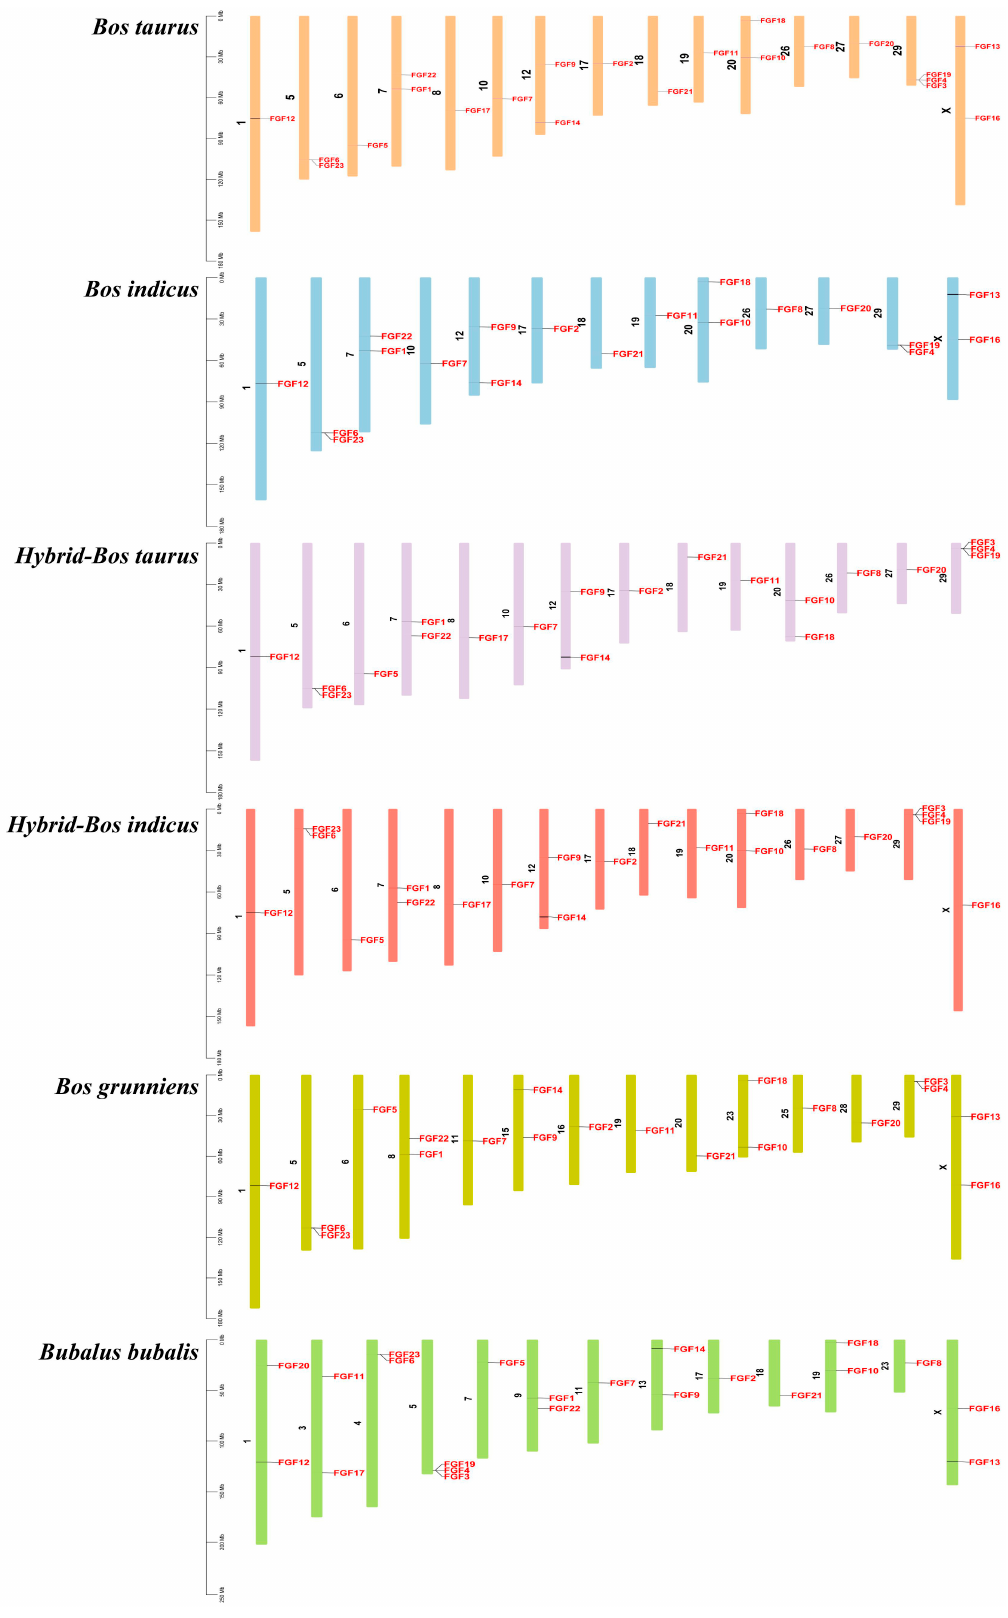
Figure 3. The chromosomal distribution of FGFs gene.